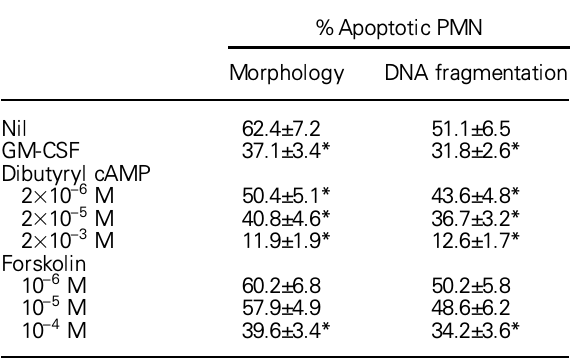
Table 1. Modulating effects of GM-CSF and cAMP-elevating agents on spontaneous neutrophil apoptosis a